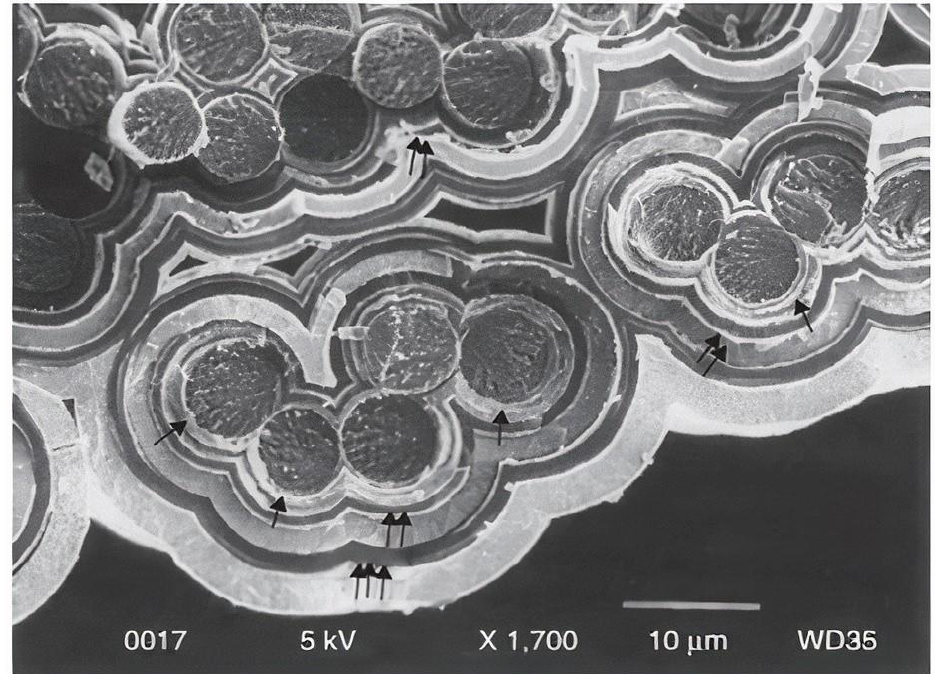
Figure 13. Self-healing with multi-layered SiC matrix deposited by pulsed CVI viewed in a transverse direction [162].